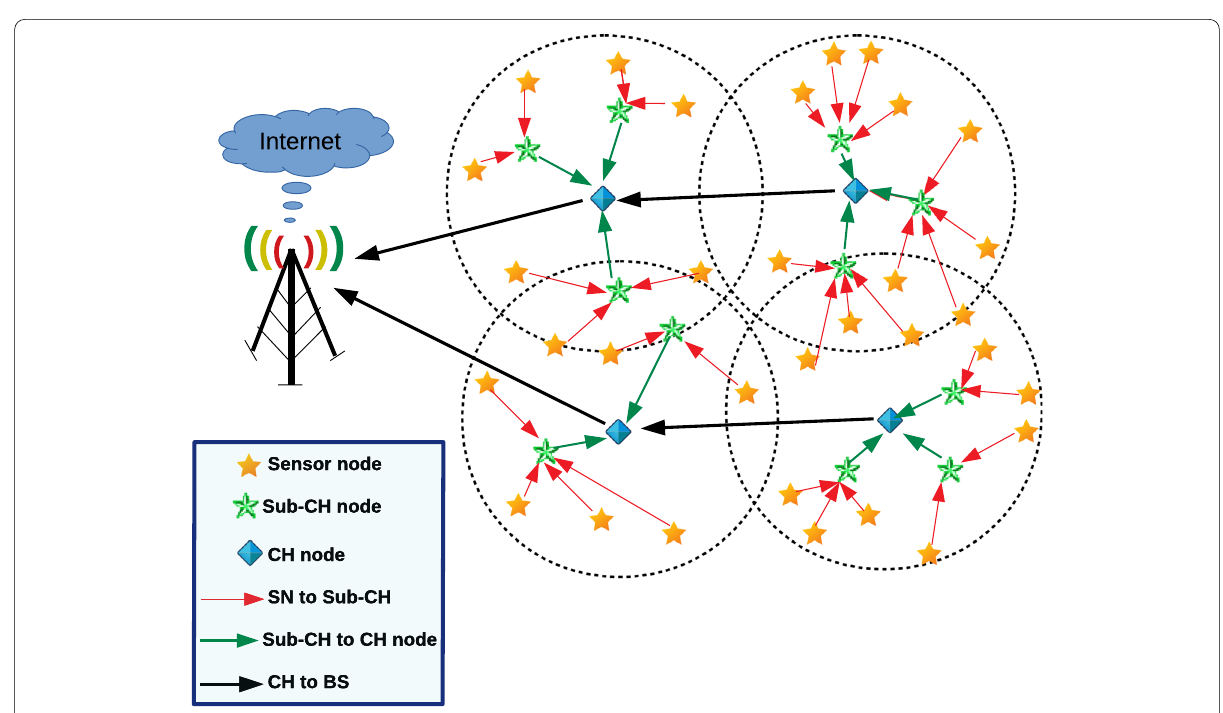
Fig. 2 Sub-cluster LEACH conceptual